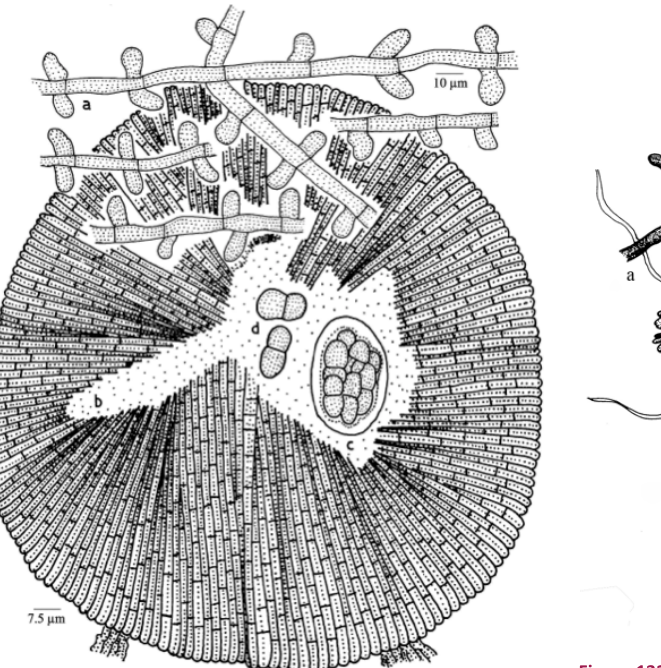
Figure-132. Asterina arkemibeyi a - Appressorium; b - Thyriothecium; c - Ascus; d - Ascospores; e -